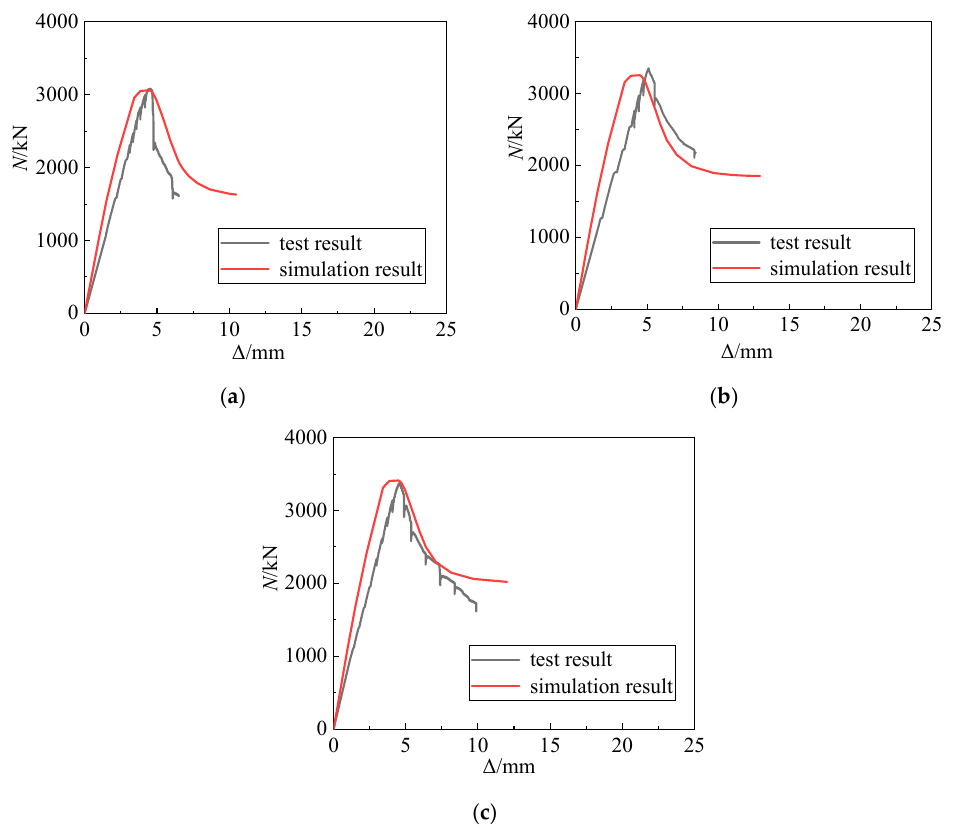
Figure 12. Comparing the simulation curves with the test curves: ( a ) specimen A1; ( b ) specimen A2; ( c ) specimen A3.